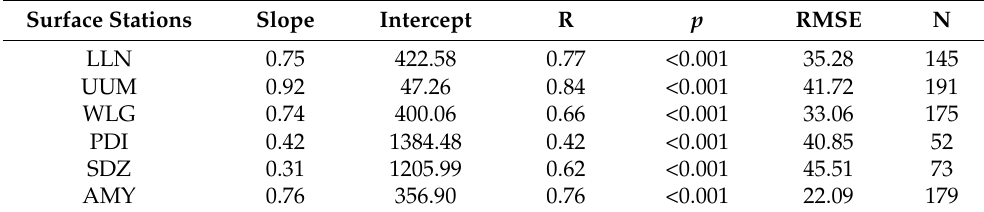
Figure 2. Correlation analysis of satellite-observed XCH 4 concentrations and surface-observed CH 4 concentrations. Table 2. The correlation between CH 4 concentrations observed by surface stations and